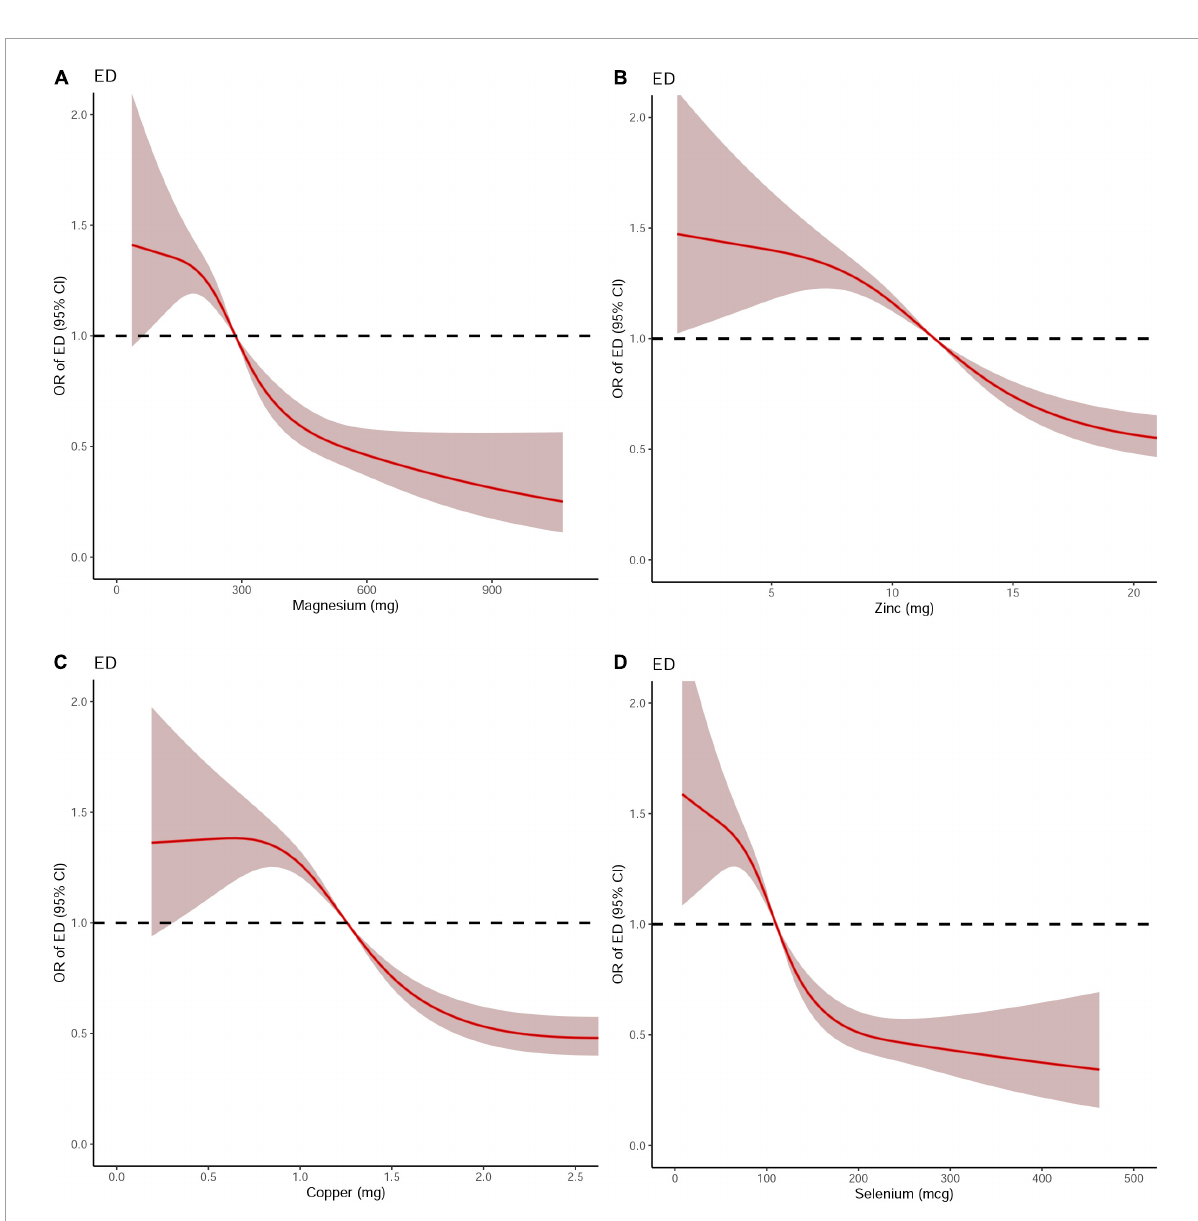
FIGURE2 The dose-response analysis of dietary metal intake and erectile dysfunction before propensity score matching. (A) Magnesium; (B) Zinc; (C) Copper; and (D)